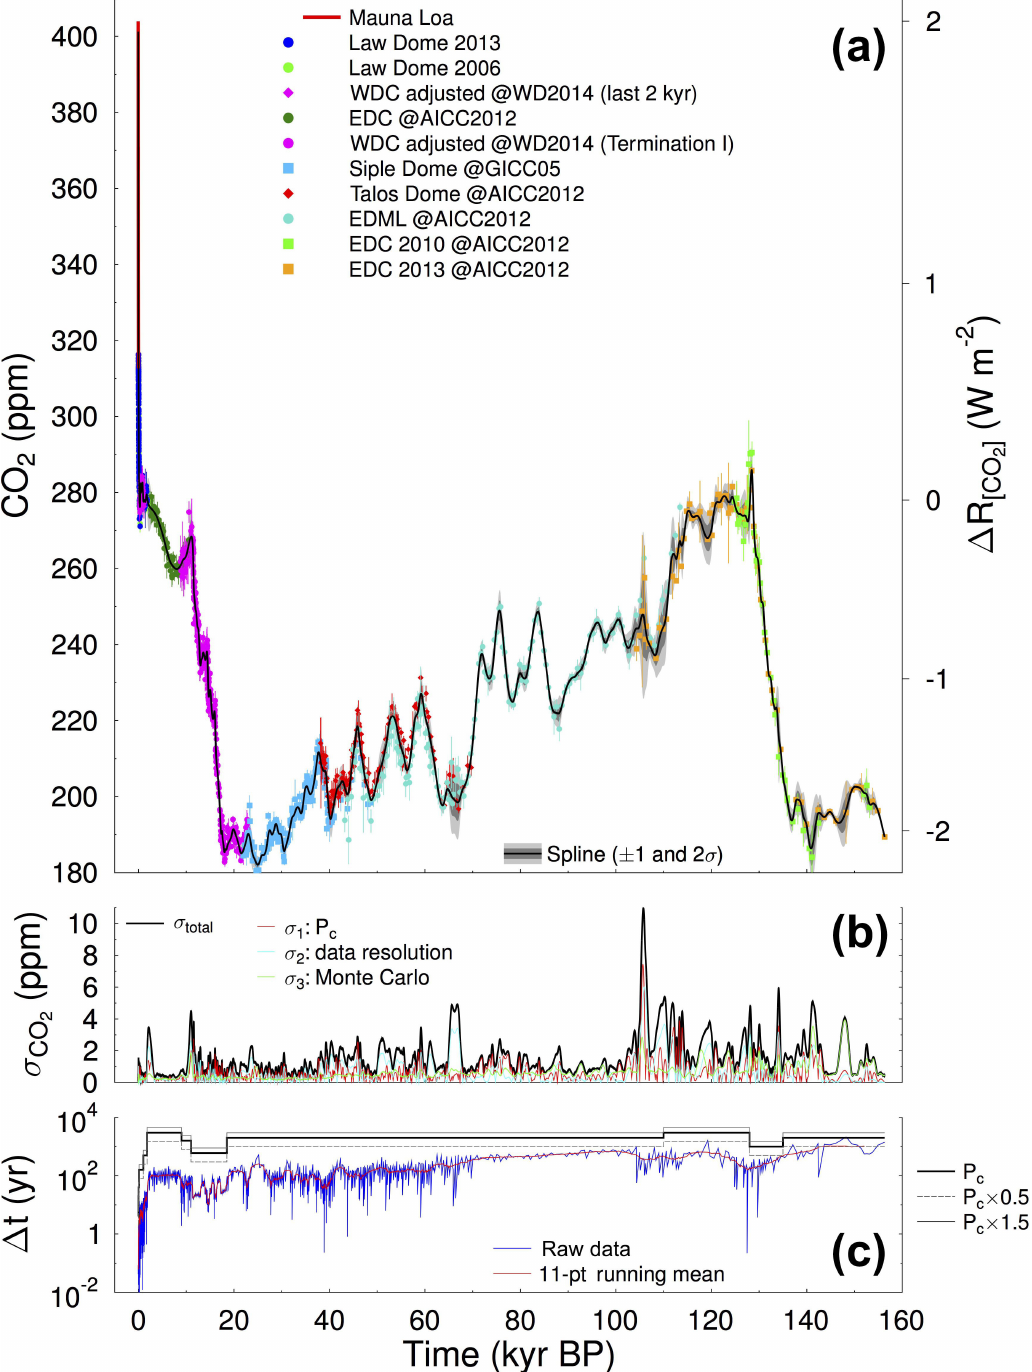
Figure 1. CO 2 spline covering all data: 2016CE–156307BP. Error bars around the ice core data points are ± 2 σ . WDC data have been adjusted to reduce offsets; see text for details. In (a) the right axis contains the resulting radiative forcing (cid:49)R [ CO ln (CO 2 / (278ppm))Wm − 2 calculated after Myhre et al. (1998). (b) Total uncertainty of the spline based on three individual error sources; see text for details. (c) Temporal resolution ( (cid:49)t ) of the CO 2 data points underlying the spline on a log scale. Additionally, the prescribed time-dependent cutoff period P c is plotted, including its variation by ± 50%, which has been used to determine σ 1 .